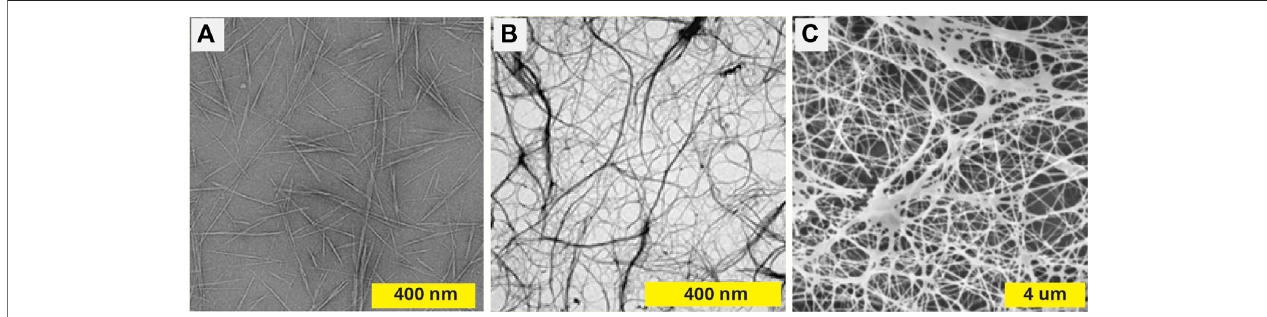
FIGURE2 | Electron microscopy ofdried nanocelluloses prepared from differentsources: (A) TEM image of cellulose nanowhiskers obtained from sisal (Reprinted with permission from (Garcia de Rodriguez, et al., 2006). Copyright 2006 Springer) (B) TEM image of cellulose nano fi bers obtained from banana peels by high-pressure homogenizer (Reprinted with permission from (Pelissari et al., 2014). Copyright 2014 Springer). (C) SEM of bacterial nanocellulose produced by Gluconacetobacter xylinus (Reproduced with permission from (Ataide et al.,